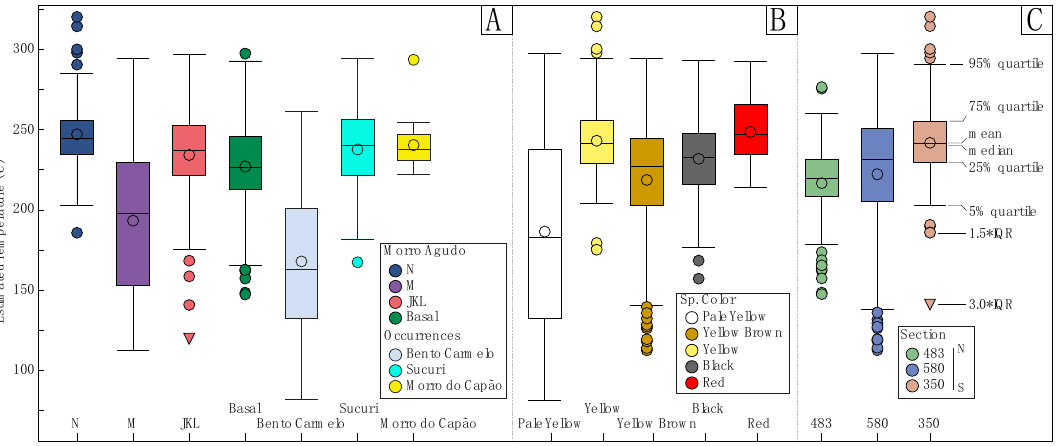
Figure 16. Estimated formation temperatures of sphalerite after Frenzel et al. [27] distinguished by orebody ( A ), sphalerite color ( B ), and section in the Morro Agudo deposit ( C ).